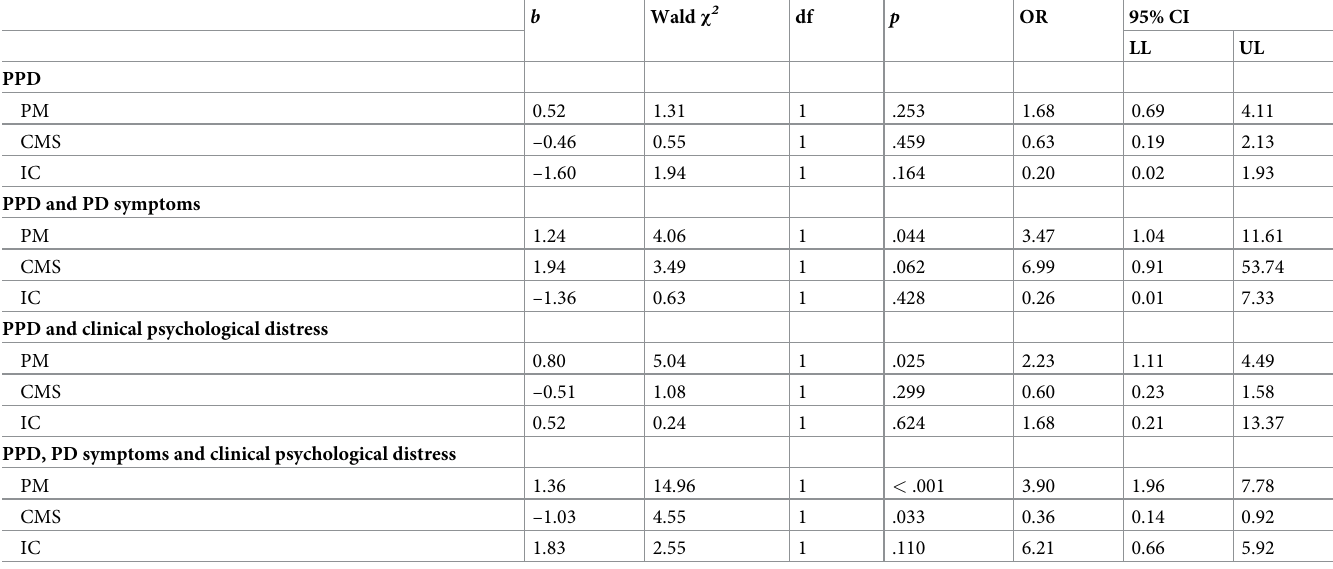
Table 4. Multinomial logistic regression analysis of PRFQ-I scores on the presence of psychopathology in mothers with PPD compared with mothers with no PPD (n = 344),